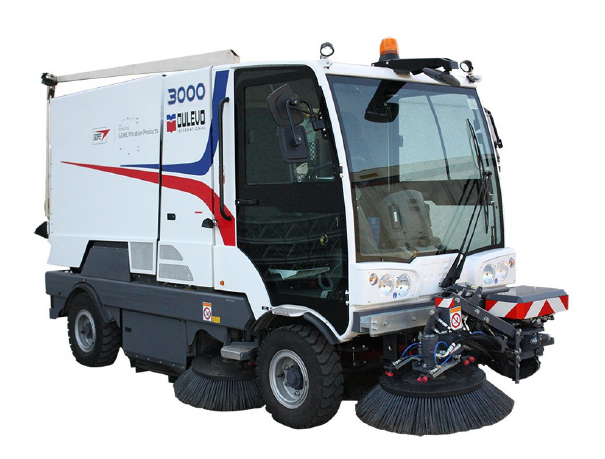
Figure 1. A typical three-brushes street sweeper (image courtesy of Dulevo International